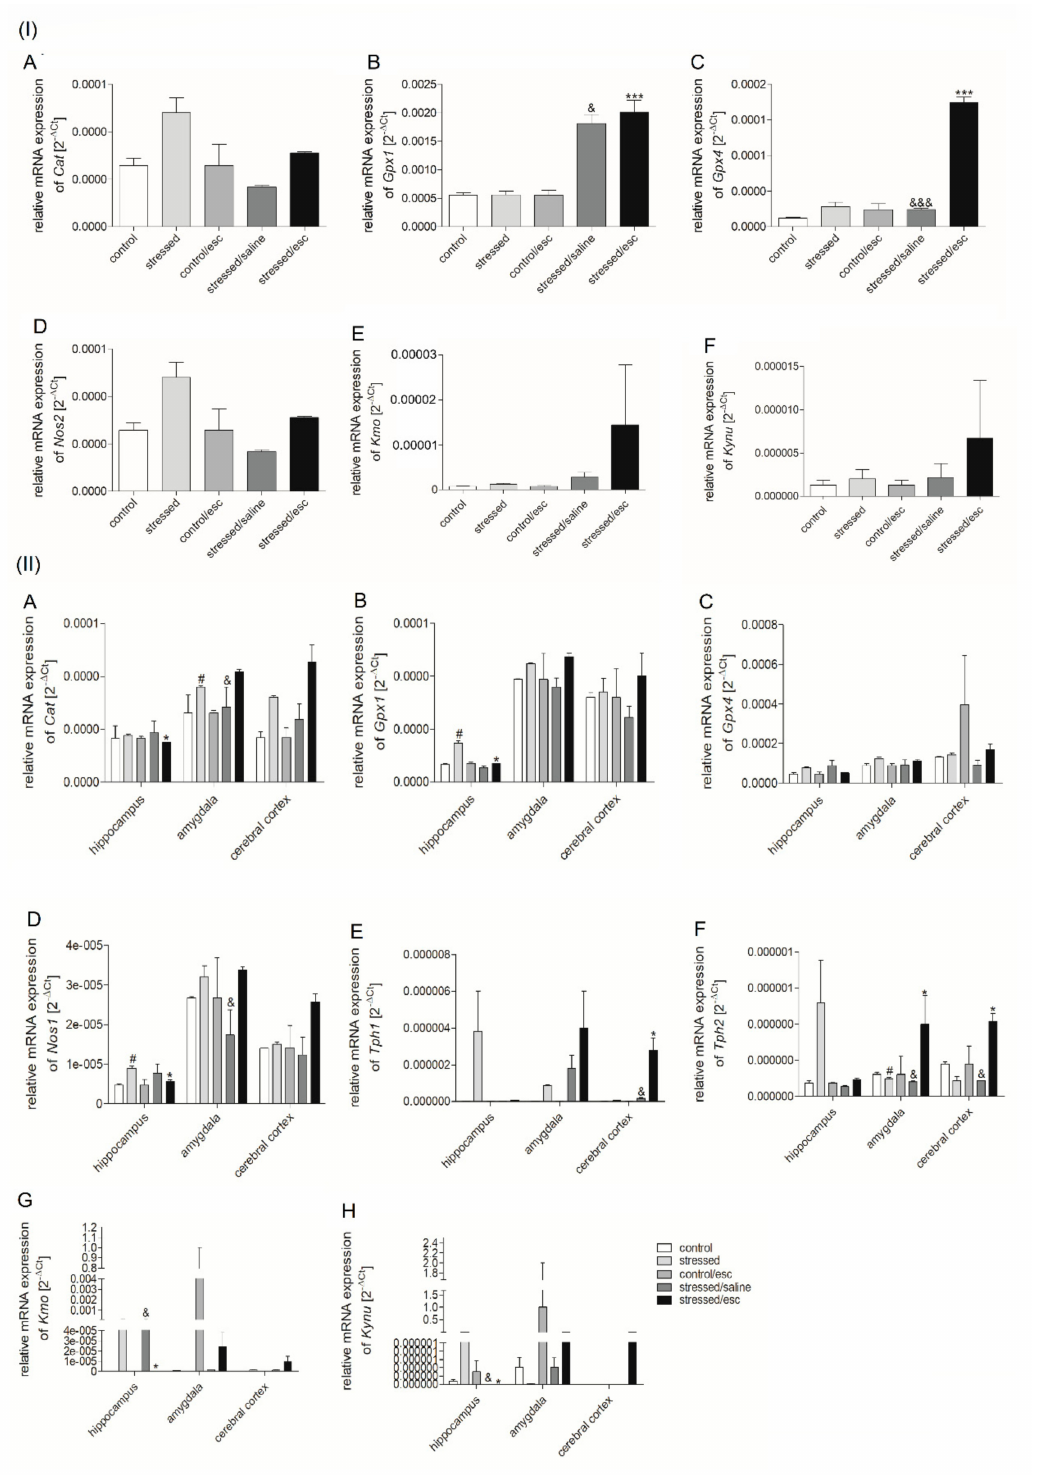
Figure 2. ( I ) mRNA expression of Cat ( A ), Gpx1 ( B ), Gpx4 ( C ), Nos2 ( D ) Kmo ( E ), Kynu ( F ) in PBMCs and ( II ) mRNA expression of CAT ( A ), Gpx1 ( B ), Gpx4 ( C ), Nos1 ( D ), Tph1 ( E ), Tph2 ( F ), Kmo ( G ), Kynu ( H ) in the brain structures (hip- pocampus, amygdala, cerebral cortex) of animals exposed to CMS for two weeks (control, stressed) and in animals exposed to CMS for seven weeks and administered vehicle (1 mL/kg) or escitalopram (10 mg/kg) for five weeks (control/esc, stressed/saline, stressed/esc). Relative gene expression levels were estimated using a 2 − ∆ Ct (Ctgene–Ct18S) method. Data represent means ± SEM. n = 6. * p < 0.05, *** p < 0.001 stressed group relative to stressed/esc group; # p < 0.05 stressed group relative to control group; & p < 0.05, &&& p < 0.001 stressed/esc group relative to stressed/saline